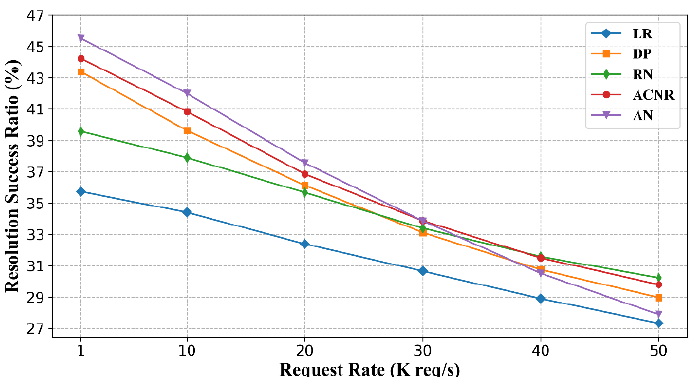
Figure 5. Name resolution success rate comparison for each algorithm with different name resolution request rates.